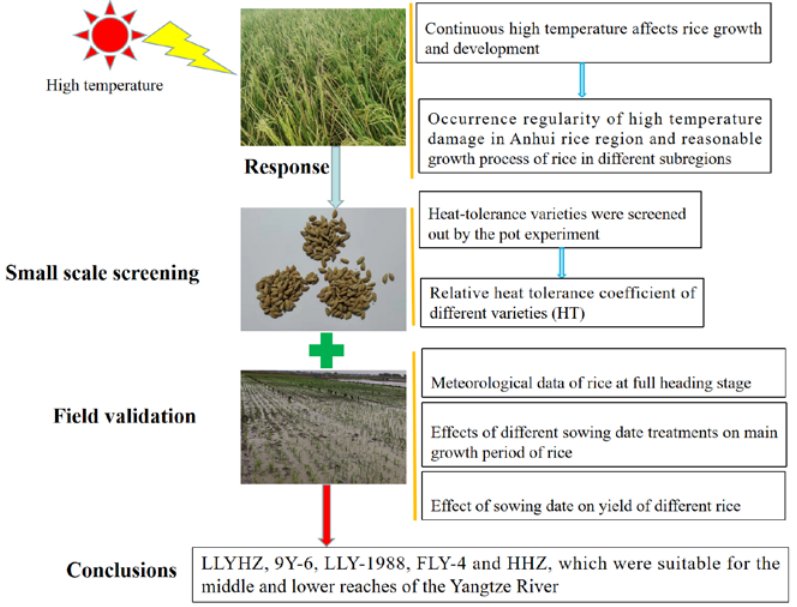
Figure 7. Screening of heat-tolerant indica rice varieties in the middle and lower reaches of the Yangtze River.